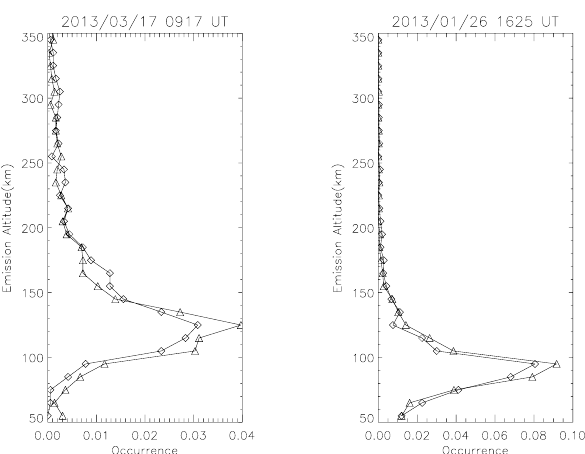
Fig. 4. Altitude map of a ray structure of a discrete aurora as ob- tained from all-sky images in Fig. 1. The superposed dots show the estimated emission altitudes, and the blue to yellow colors indicate low (50km) to high ( > 400km) altitudes. The full-color original image is also shown in the background.